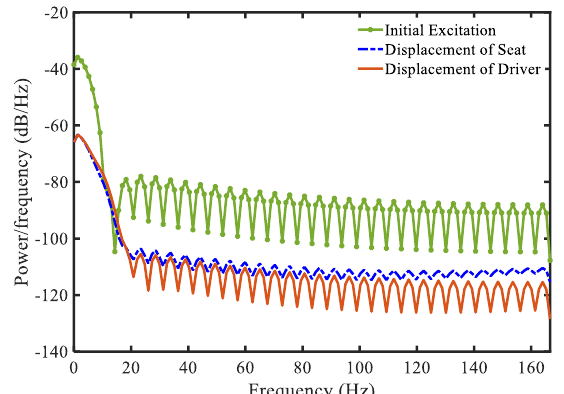
Figure 3. Simulation result of power spectral density of displacements under random bump road excitation.